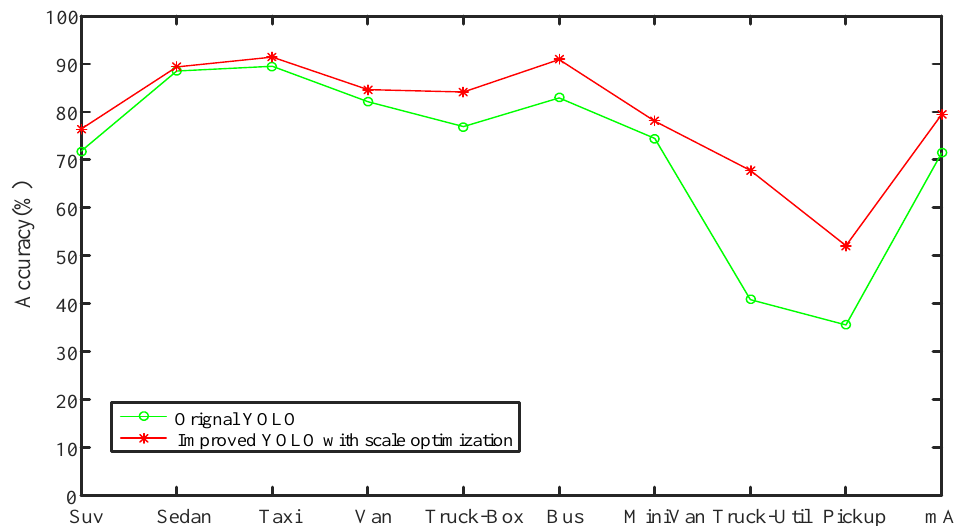
Figure 7. Comparison of accuracy between the original YOLO algorithm and its improved algorithm.